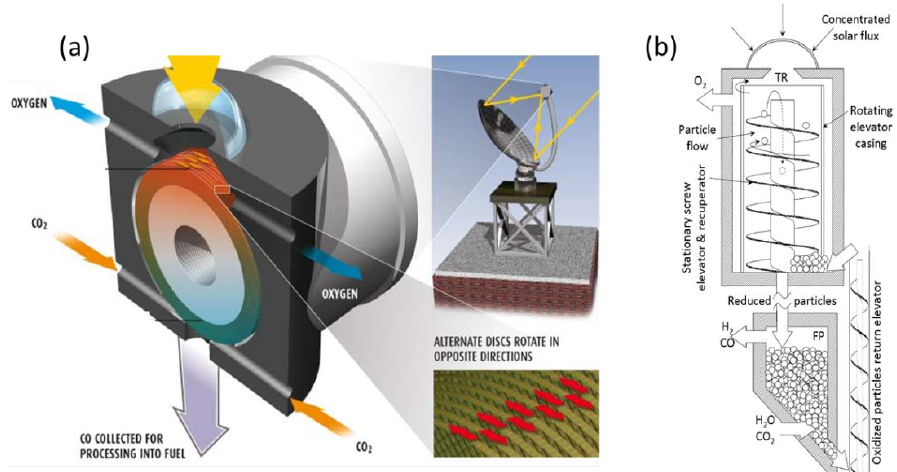
Figure 14. Scheme of integrated reactors with solid oxide displacement between redox steps: ( a ) Diagram of CR5 reactor; ( b ) Prototype of circulating dense bed reactor.